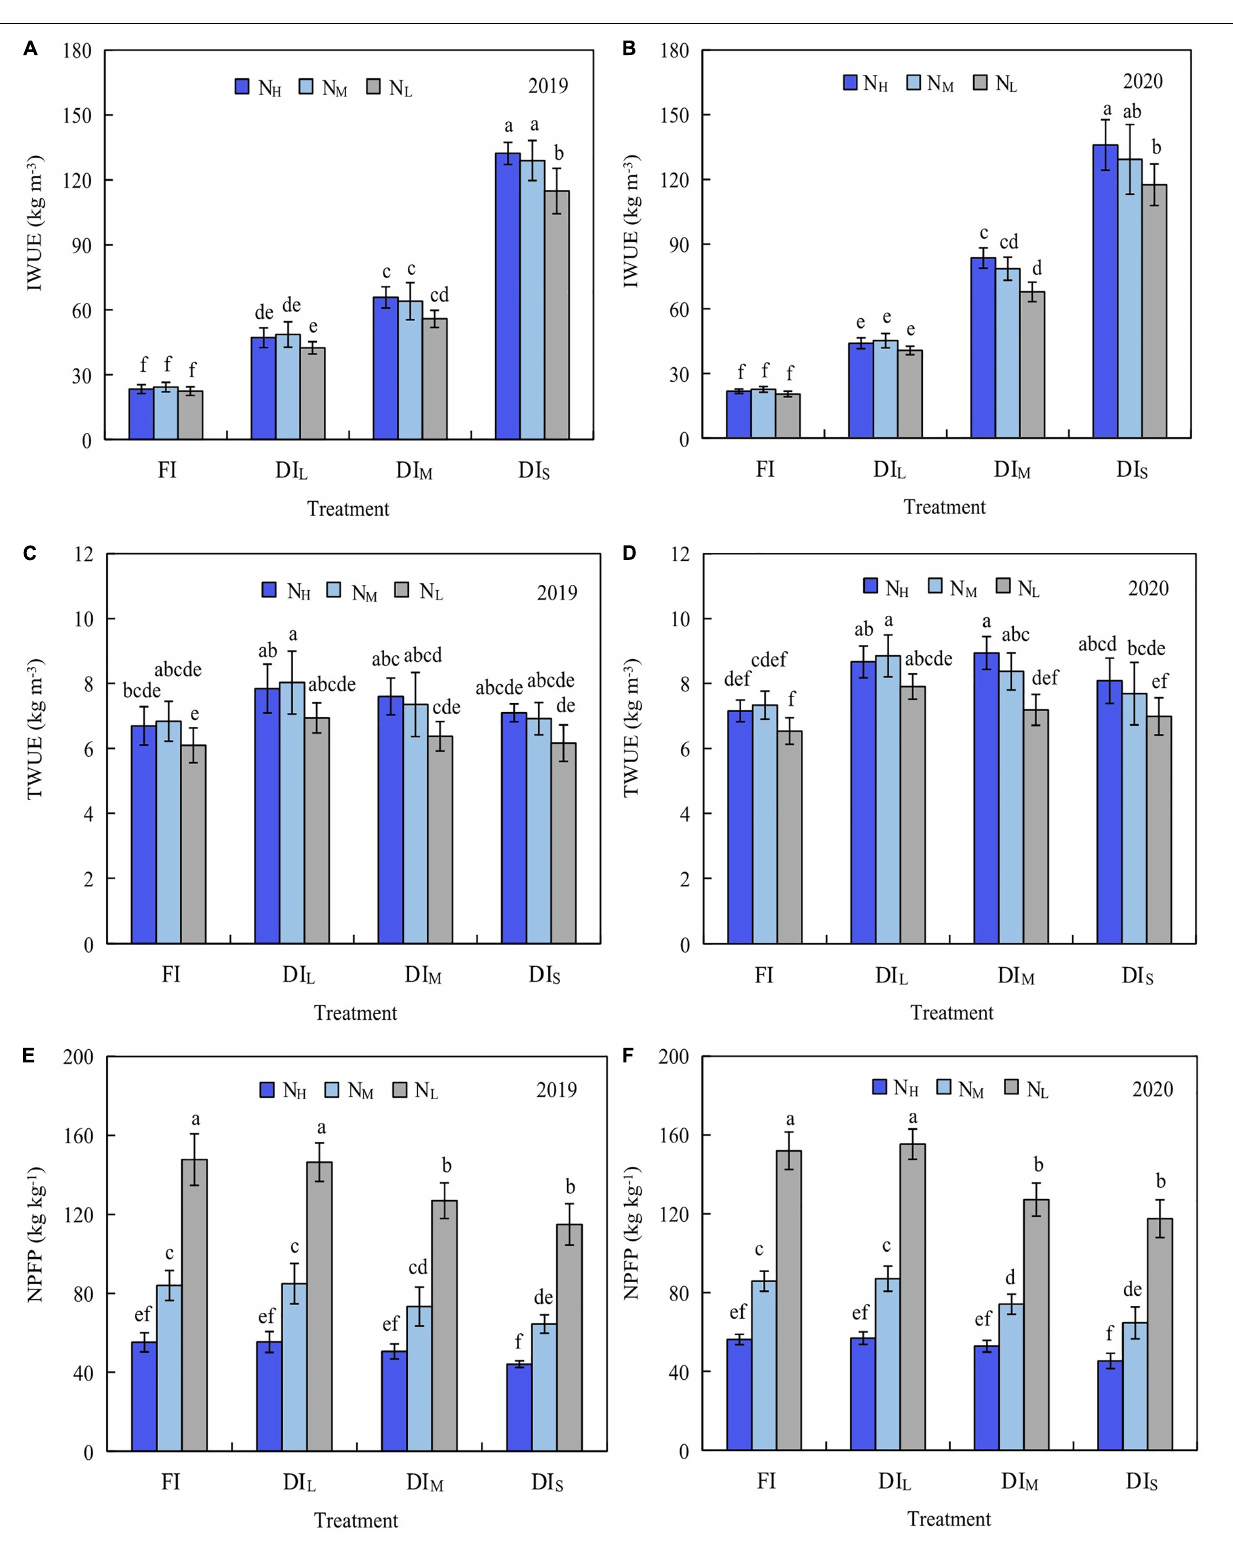
Frontiers in Plant Science |